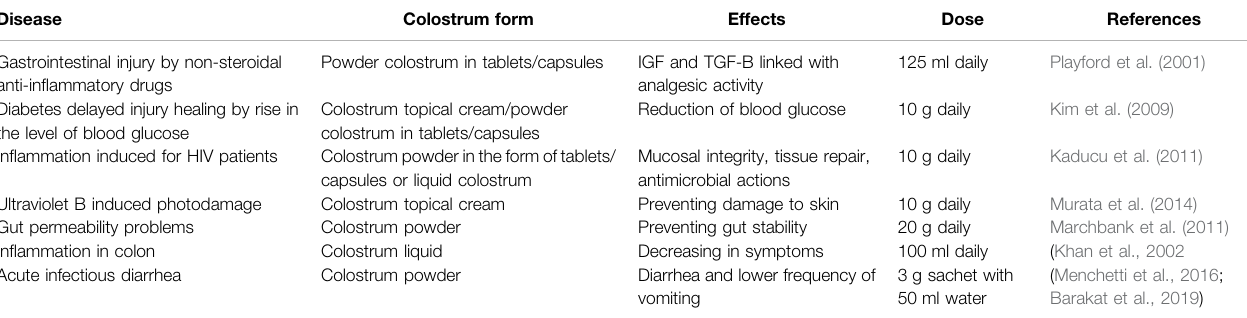
TABLE 2 | Different bovine colostrum forms used in some types of diseases.